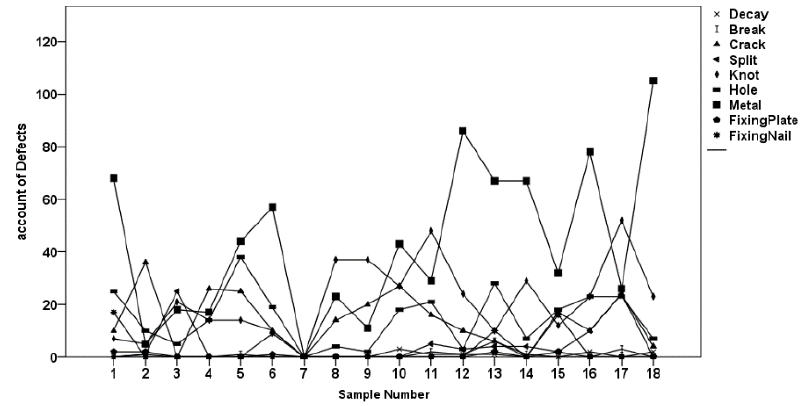
Figure 4. Defect accounts for 18 timbers.